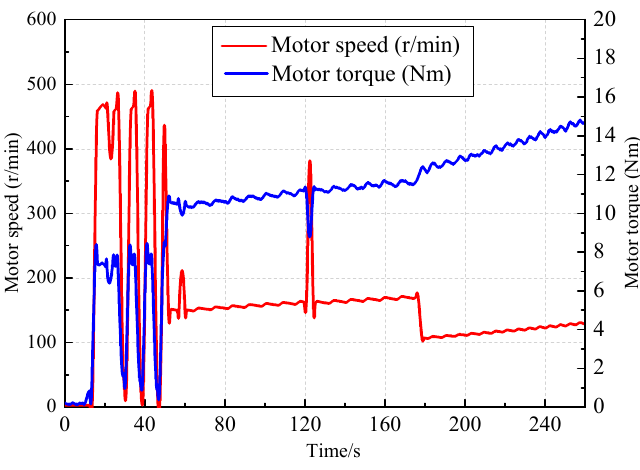
Figure 18. Motor speed and torque curves.